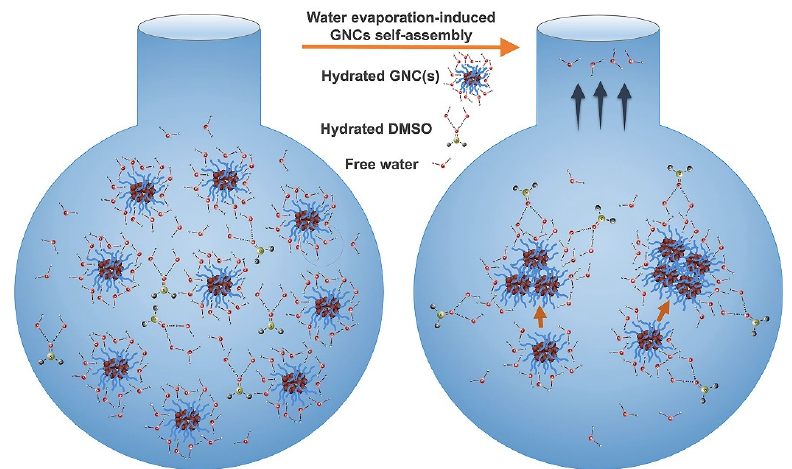
Figure 3. Schematic diagram of AuNCs self-assembly induced by dynamic water evaporation in water–DMSO binary solvents. Copyright 2018 American Chemical Society.